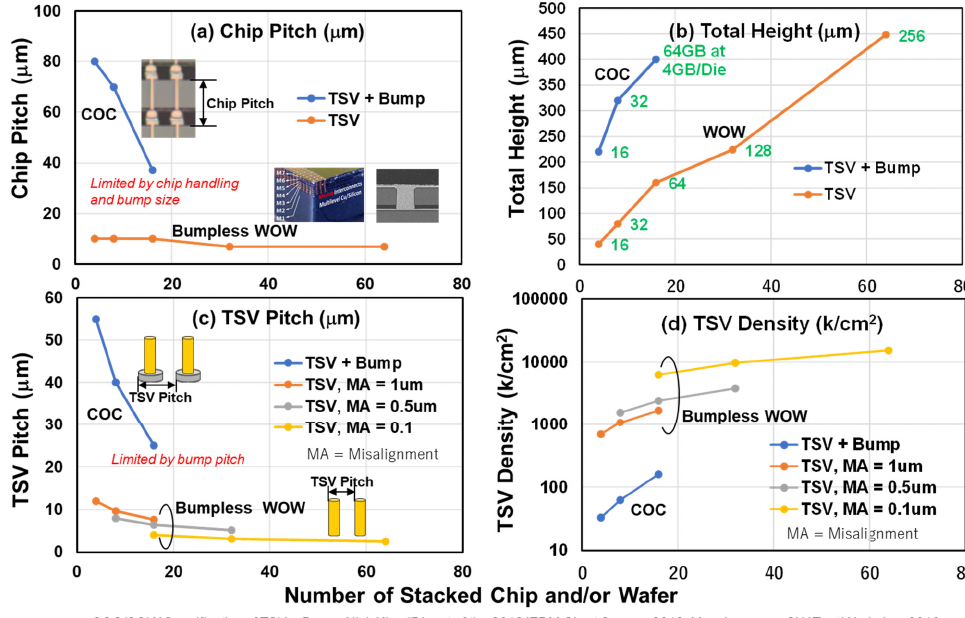
Figure 5. Trends of TSV interconnects as a function of number of stacked layers: ( a ) chip pitch, ( b ) total height, ( c ) TSV pitch, and ( d ) TSV density. For bumpless process, TSV diameter and space between pads were 9 to 1 μ m and 1 μ m, varied with misalignment (MA), respectively.